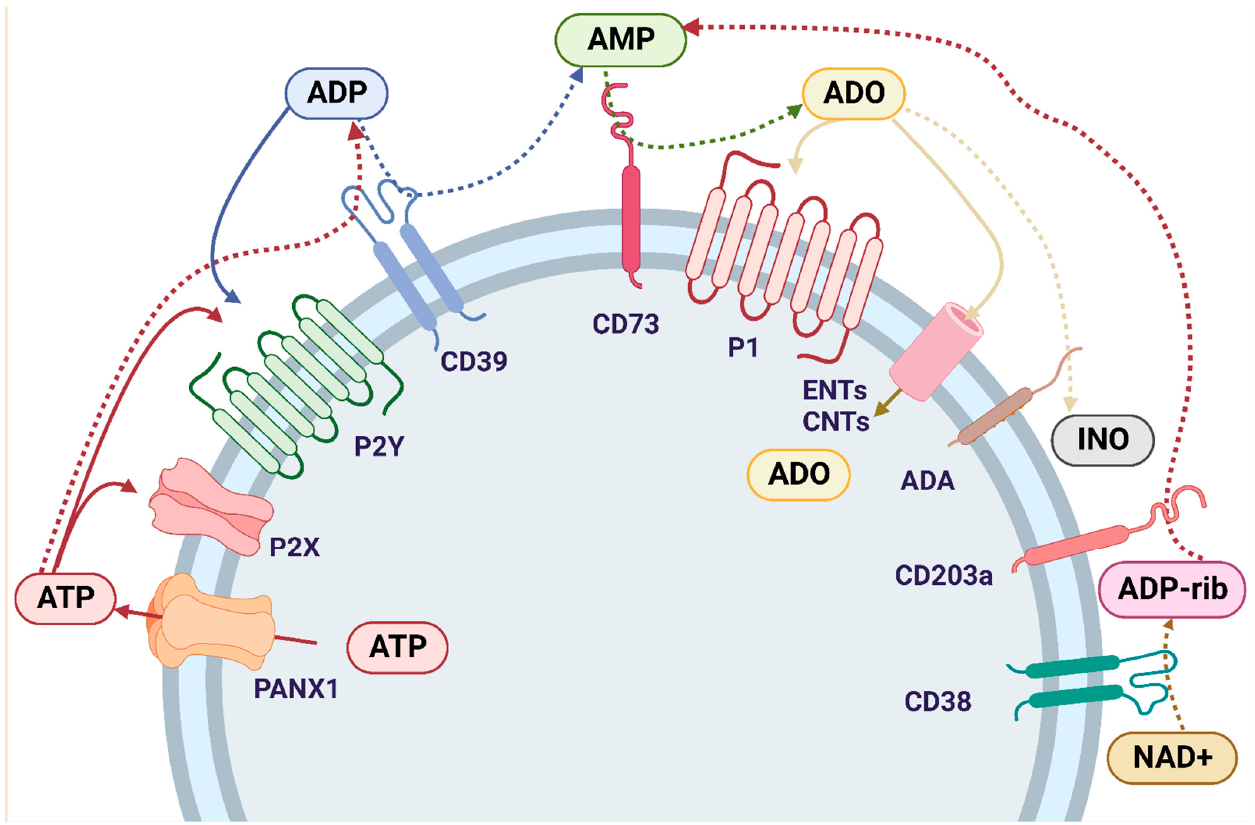
Figure 2. Purinergic signaling cascade: Intracellular ATP is externalized by the PNX1 channel and activates P2 receptors. P2Rs are divided into two major categories: P2X1-7 and P2Y 1,2,4,6,11–14 . ATP is hydrolyzed by E-NTPDase1/CD39 to ADP, which also binds to P2YR and is further hydrolyzed by CD39 to AMP. AMP is also formed through an alternative pathway that involves the enzymes NAD+-glycohydrolase/CD38, which converts NAD+ to ADP-ribose, and NPP1/CD203a, which metabolizes ADP-ribose to AMP. Once AMP is formed by the canonical and/or non-canonical pathway, it is hydrolyzed by ecto-5 ′ -nucleotidase/CD73 to ADO, thus connecting both adenosinergic pathways. ADO binds to the P1 receptors, which are divided into A1, A2A, A2B and A3, each with different ligand affinities. ADO is internalized into the cell through ENTs or CNTs and/or it is deaminated to INO by ADA. Abbreviations: ATP (adenosine triphosphate); ADP (adenosine diphosphate); AMP (adenosine monophosphate); ADO (adenosine); INO (inosine); NAD+ (nicotinamide adenine dinucleotide); PNX1 (Pannexin-1); P2X (ionotropic purinergic receptors); P2Y (metabotropic purinergic receptors); P1 (adenosine metabotropic receptors); E- NTPDase1/CD39 (ecto-nucleoside triphosphate diphosphohydrolase 1); ENTs (nucleoside equilibrative transporters); CNTs (concentrative nucleoside transporters); ADA (adenosine deaminase).